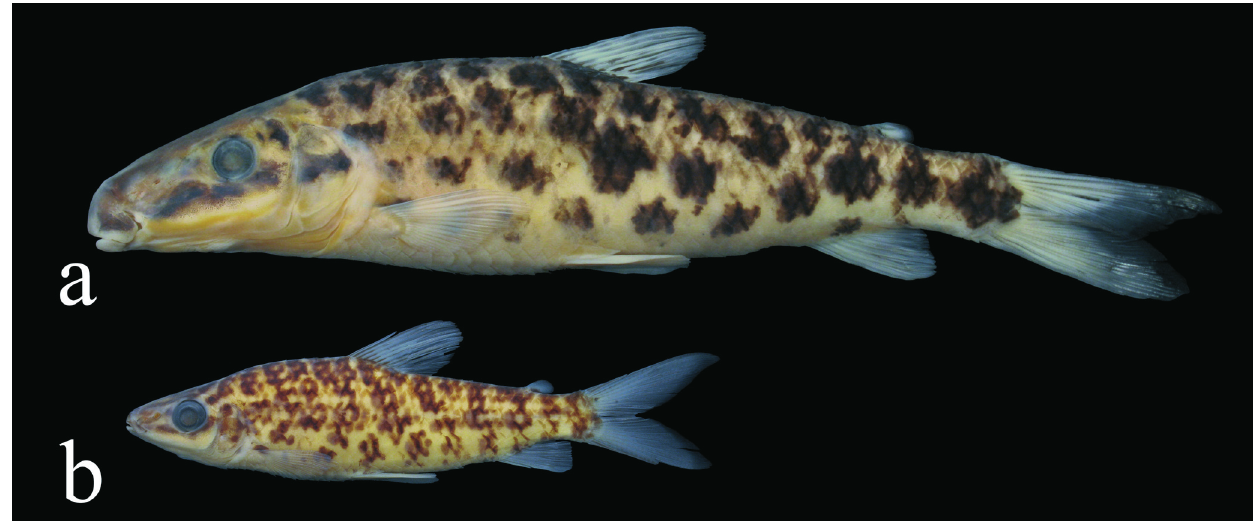
Fig. 6. Leporinus reticulatus , a – MZUSP 99736, 135 mm SL, b – holotype, MZUSP 44781, 66.2 mm